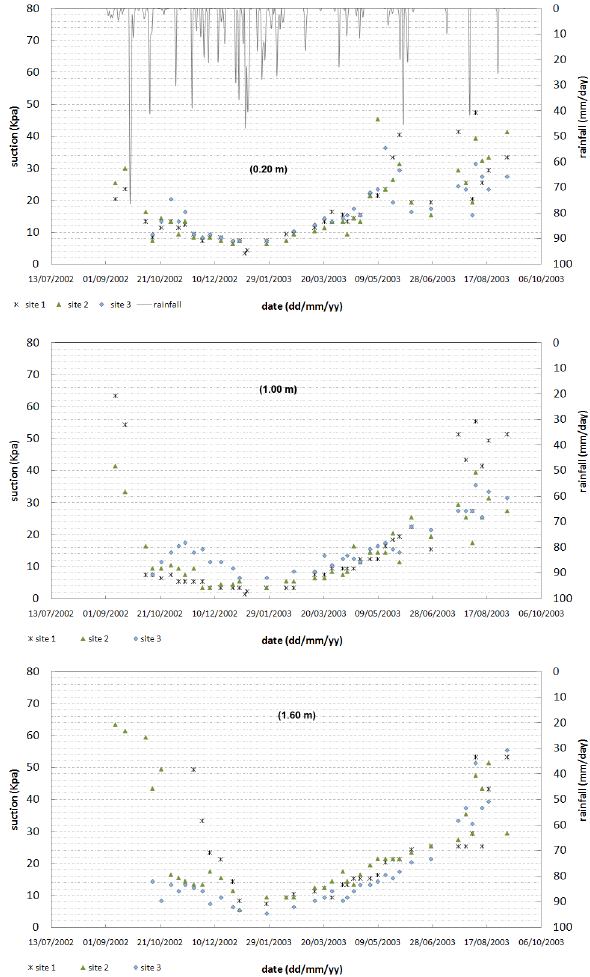
Figure 3. Suction trends recorded and daily rainfall measured by Santa Maria la Foce rain gauge at 0.20, 1.00 and 1.60m from topsoil.